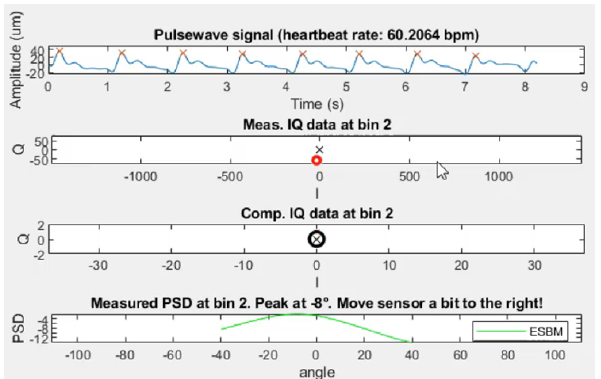
Figure 16. Result of live pulse wave extraction for subject